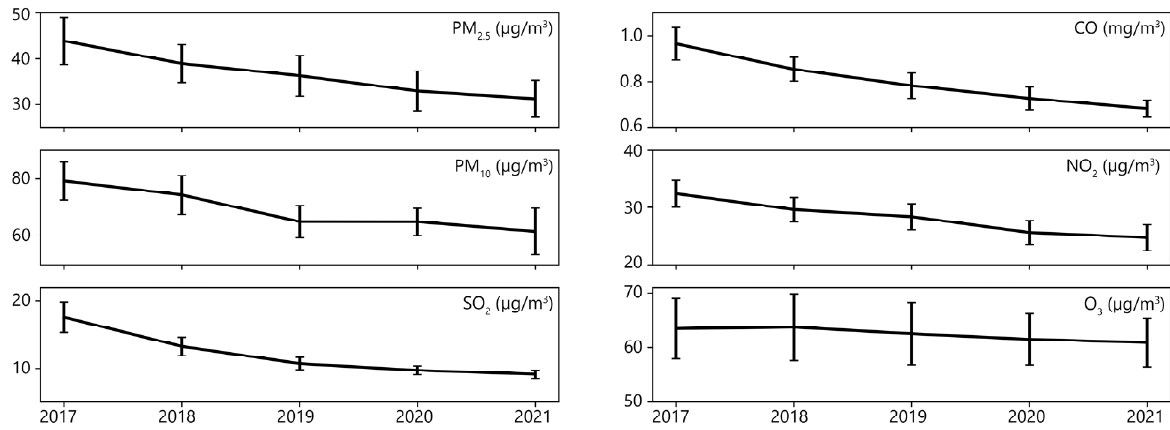
Figure 2. Annual average concentration of six air pollutants in 2017–2021. Error bar represents standard deviation.